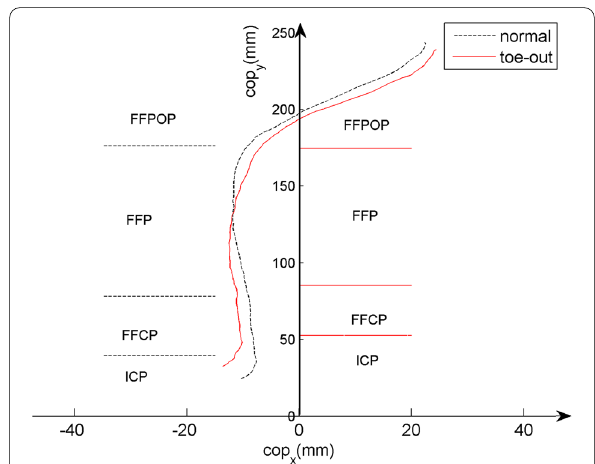
Fig. 1 The trajectory of COP of toe-out and normal gait. The y-axis is the longitudinal axis of the foot, and x-axis is perpendicular to the longitudinal foot axis. Sub-classified phases are ICP, FFCP, FFP and FFPOP